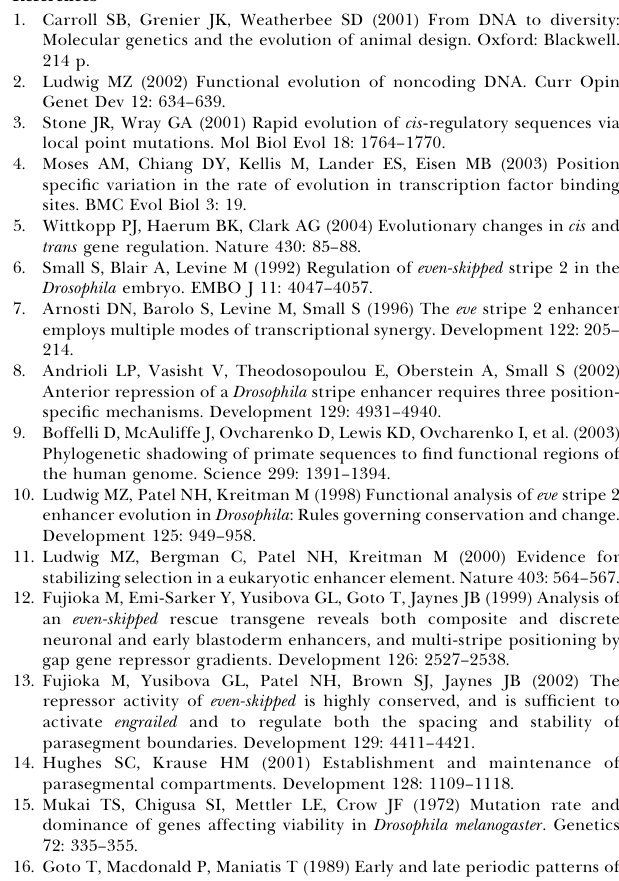
Table S1. Viability to Adulthood